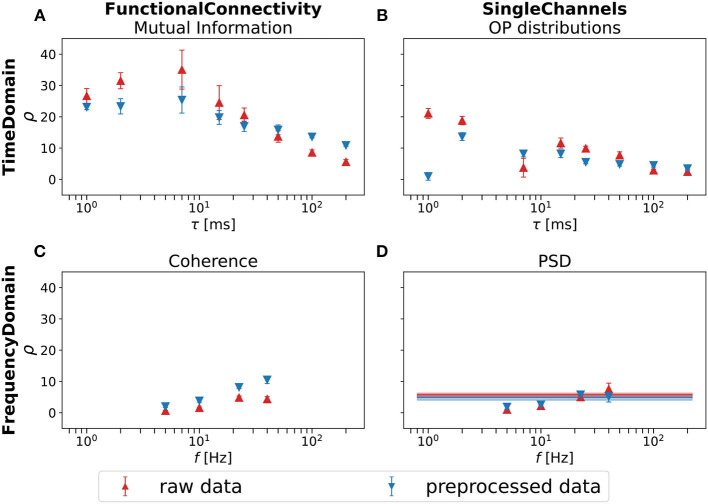
Quantification of separation of subjects in the t-SNE projections (perplexity k = 30) data set for raw and pre-processed EEG data. Both FC measures (A,C) and single-channel measures (B,D) were projected. For each projection, the ratio between the mean intra- and inter-cluster-distances was calculated. We call the Euclidean distances between points belonging to the same subject intra-cluster-distances, and the distances between the center of one cluster and its three next neighbors inter-cluster-distances. The error bars display the standard deviation over 100 t-SNE projections with different random seeds.